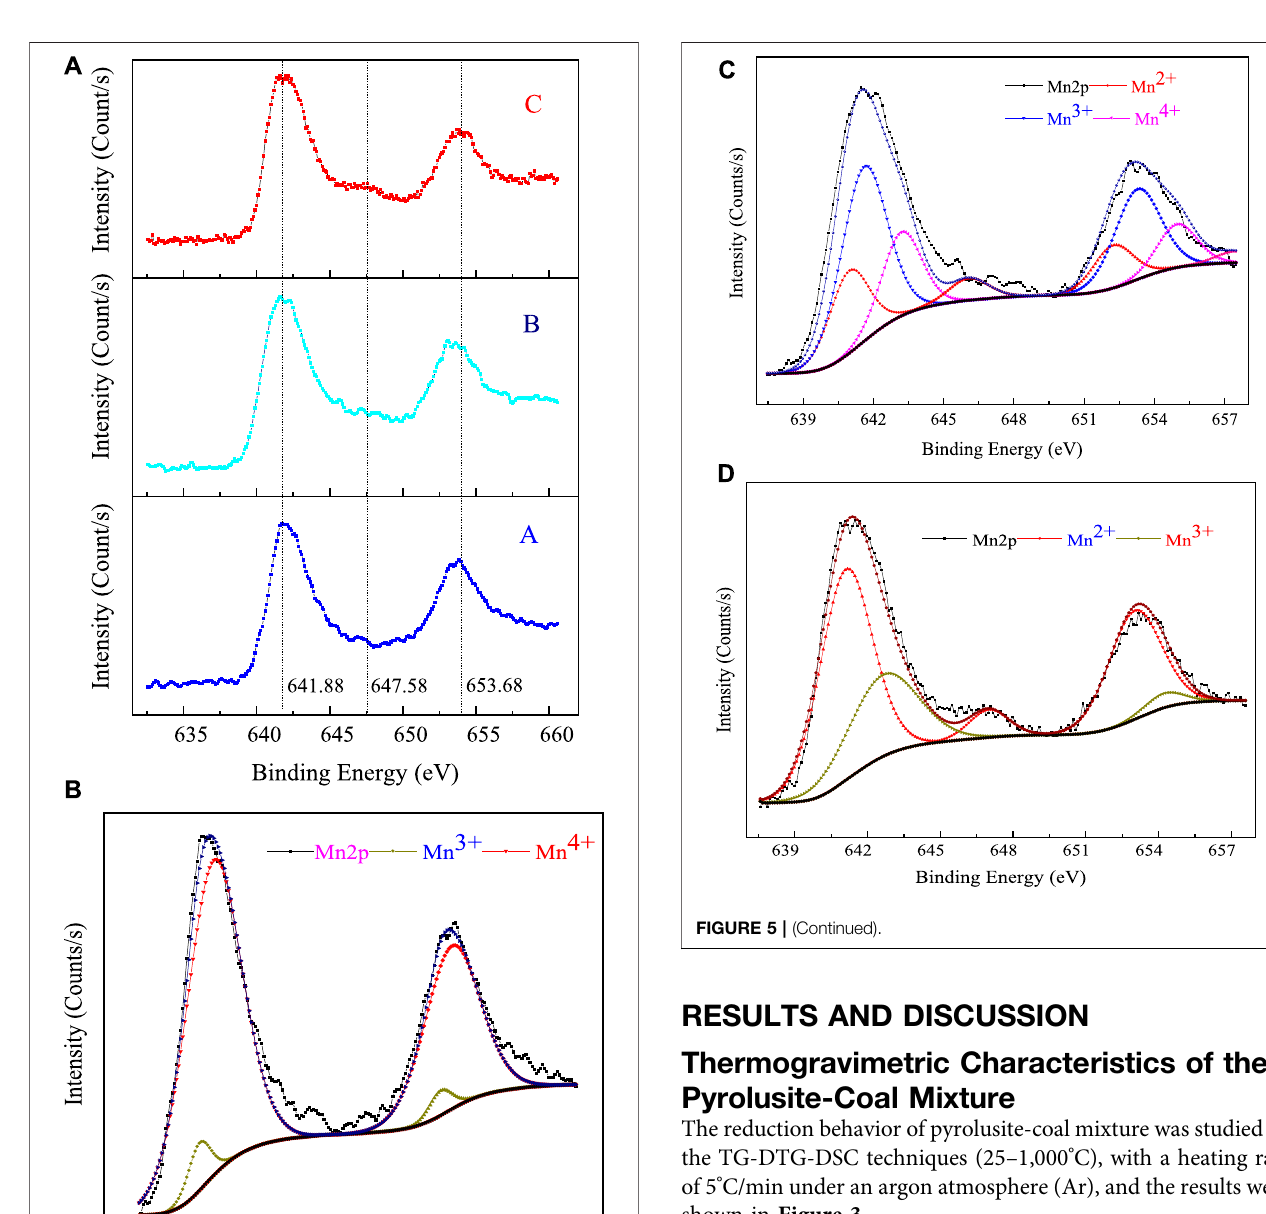
where η is the reduction ratio of the as-received pyrolusite; M 1 is the mass of Mn 4+ before the experiment, M 2 is the mass of reduced Mn 4+ after the experiment.